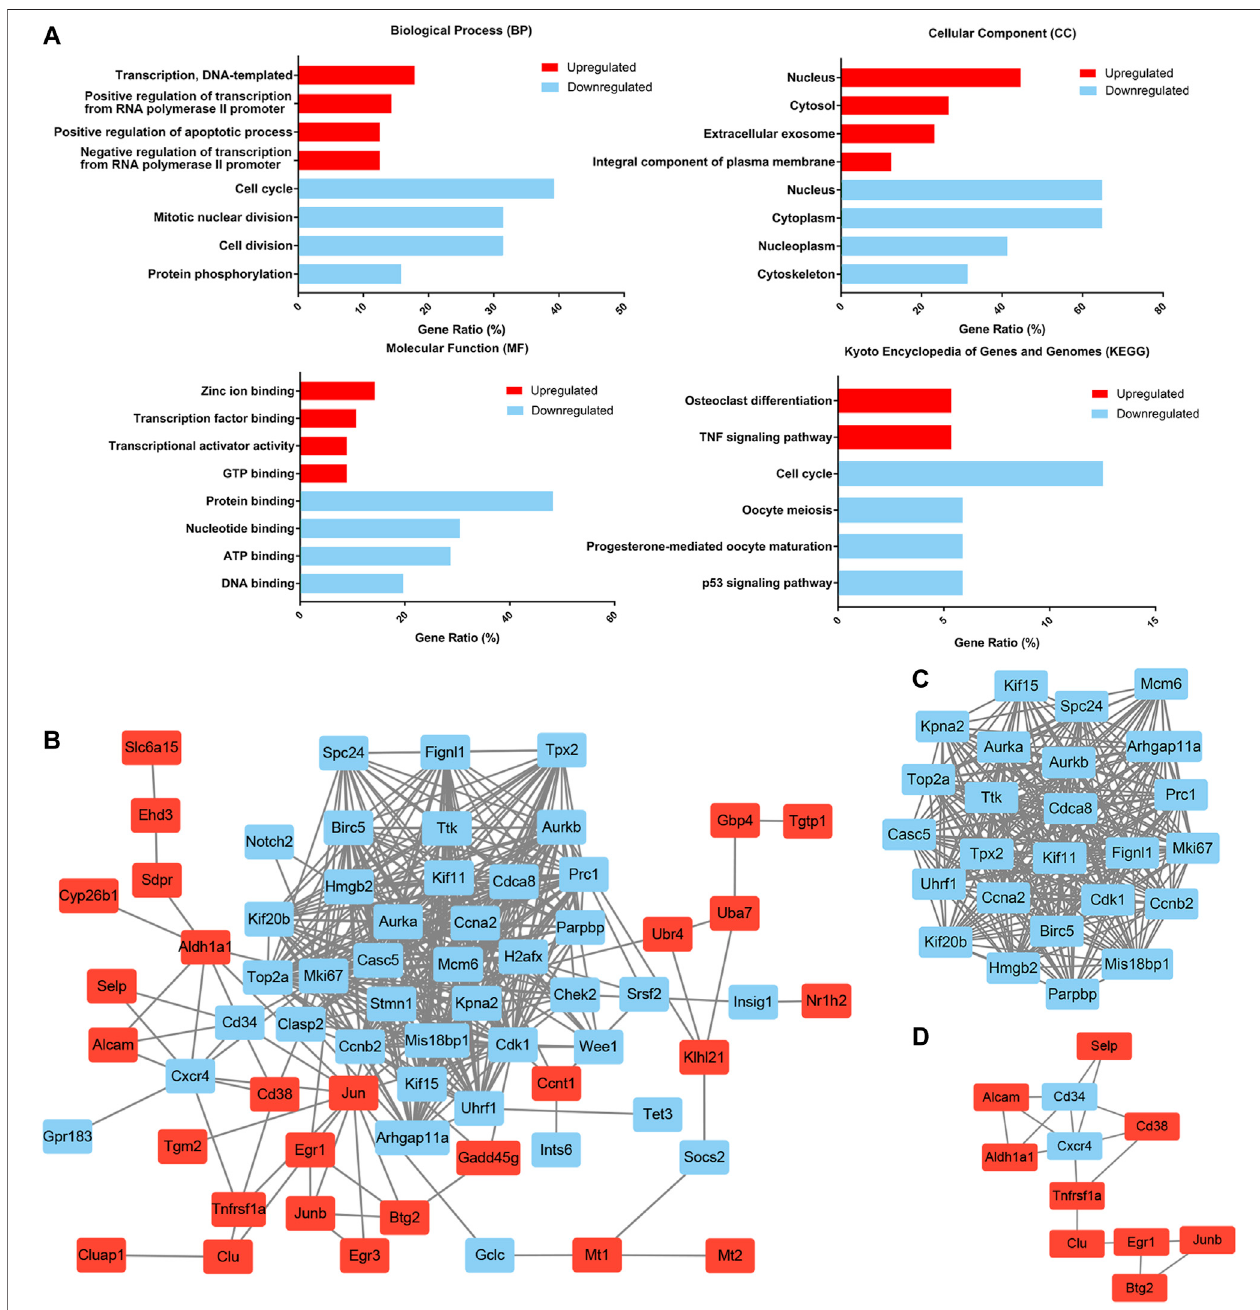
FIGURE3| Functionalenrichmentandprotein – proteininteraction(PPI)networkanalysisofcommonDEGs. (A) FunctionalenrichmentofcommonDEGs.Thegene ratio was acquired from the DAVID functional annotation tool. (B) The common DEG protein – protein interaction (PPI) network contained 67 nodes and 413 edges. (C) Module 1 contained 25 nodes and 286 edges and was mainly involved in the cell cycle. (D) Module 2 contained 11 nodes and 17 edges and was mainly involved in cell adhesion molecules and the hematopoietic cell lineage. Upregulated nodes are marked in red and downregulated nodes are marked in blue.